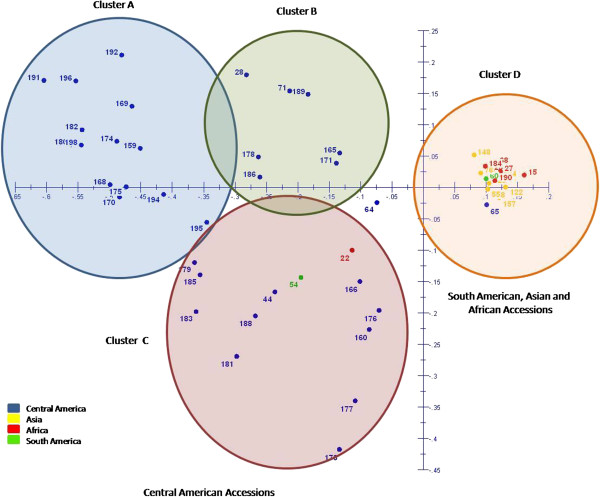
PCA scatter plot for J. curcas accessions of the JEP germplasm collection. Cluster A and B (Central Amercia accessions), Cluster C (Central America, Africa and South America accessions), Cluster D (Central America, Asia, Africa and South America accessions).